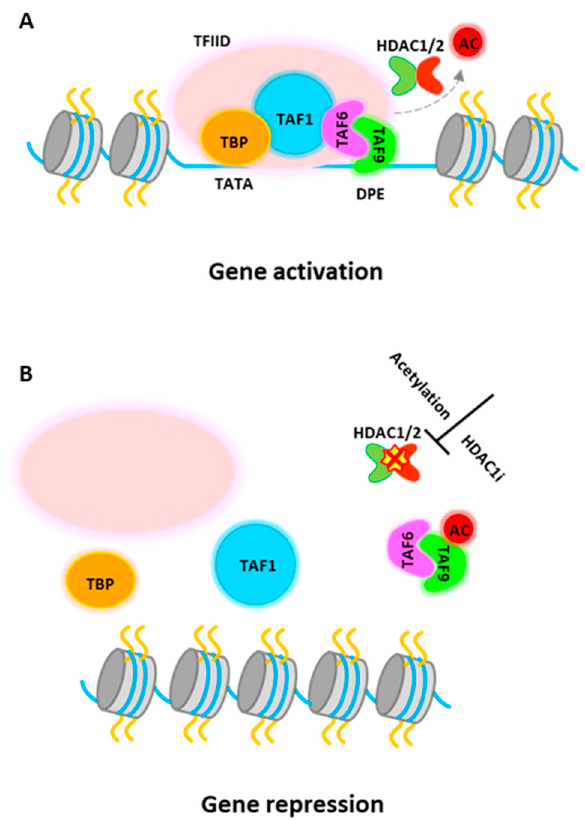
Figure 3. HDAC1 dependent dynamic transcription activation and repression at PU.1 promoter . ( A )